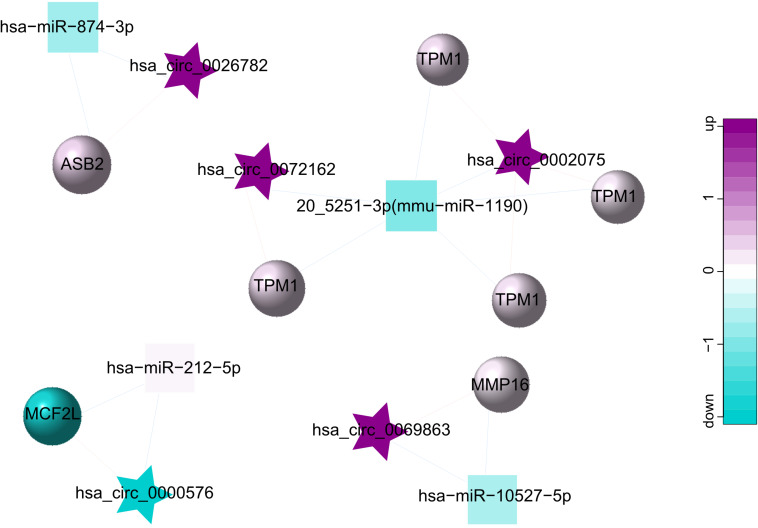
ceRNA network for 5 circRNAs (hsa_circ_0002075, hsa_circ_0000576, hsa_circ_0069863, hsa_circ_0072162, hsa_circ_0026782), 4 miRNAs (hsa-miR-212-5p, 20_5251-3p (mmu-miR-1190), hsa-miR-874-3p, hsa-miR-10527-5p) and 7 mRNAs. The star represents the circRNA, the square represents the miRNA, the circle represents the mRNA, and the edges among circRNAs, miRNAs and mRNAs represent the relationships of them. Up-regulated expression was described in purple, and down-regulated expression was described in green. The darker the color, the more significant the difference.